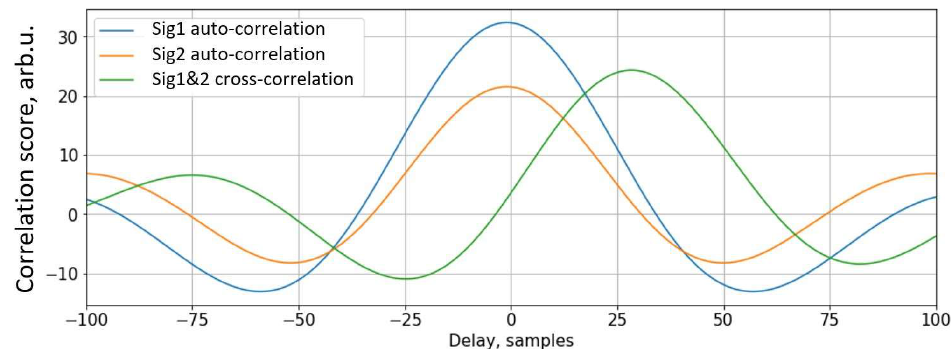
Figure 3. Comparison of auto and cross-correlation functions for a pair of magnetic signatures (arb. = arbitrary units).